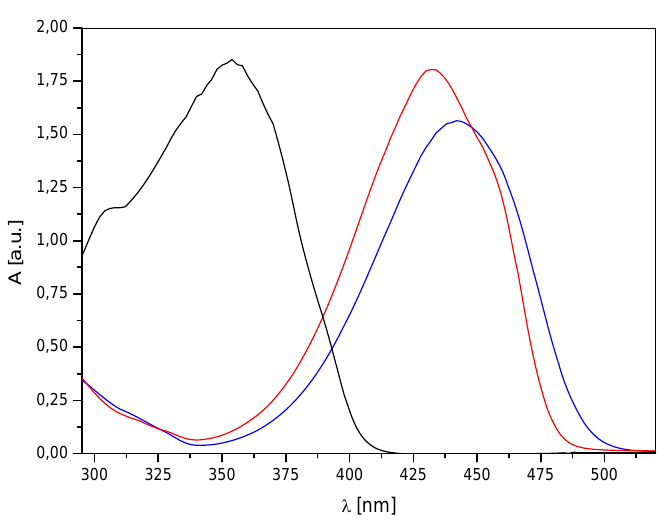
Figure 1. Absorption spectra of 4a in methanol ( ⎯⎯ ) and of 4c in methanol ( ⎯⎯ ) , toluene ( ⎯⎯